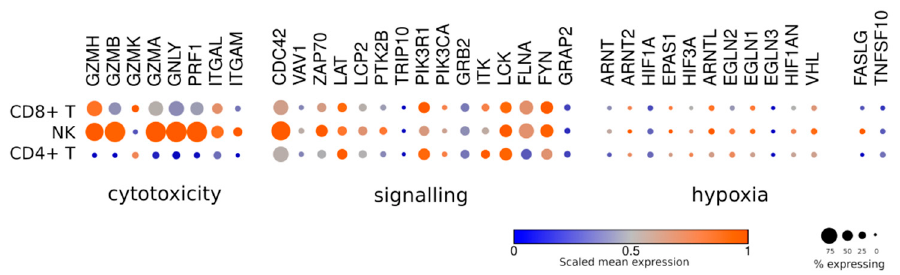
Figure 3. Expression plot for different groups of genes across the major subpopulations of human T and NK cells. “Cytotoxicity” genes encoding perforin and granzymes and the synapse-related proteins ITGAL and ITGAM; “signaling” genes encoding activation-related proteins; “hypoxia” genes involved in the cell response to